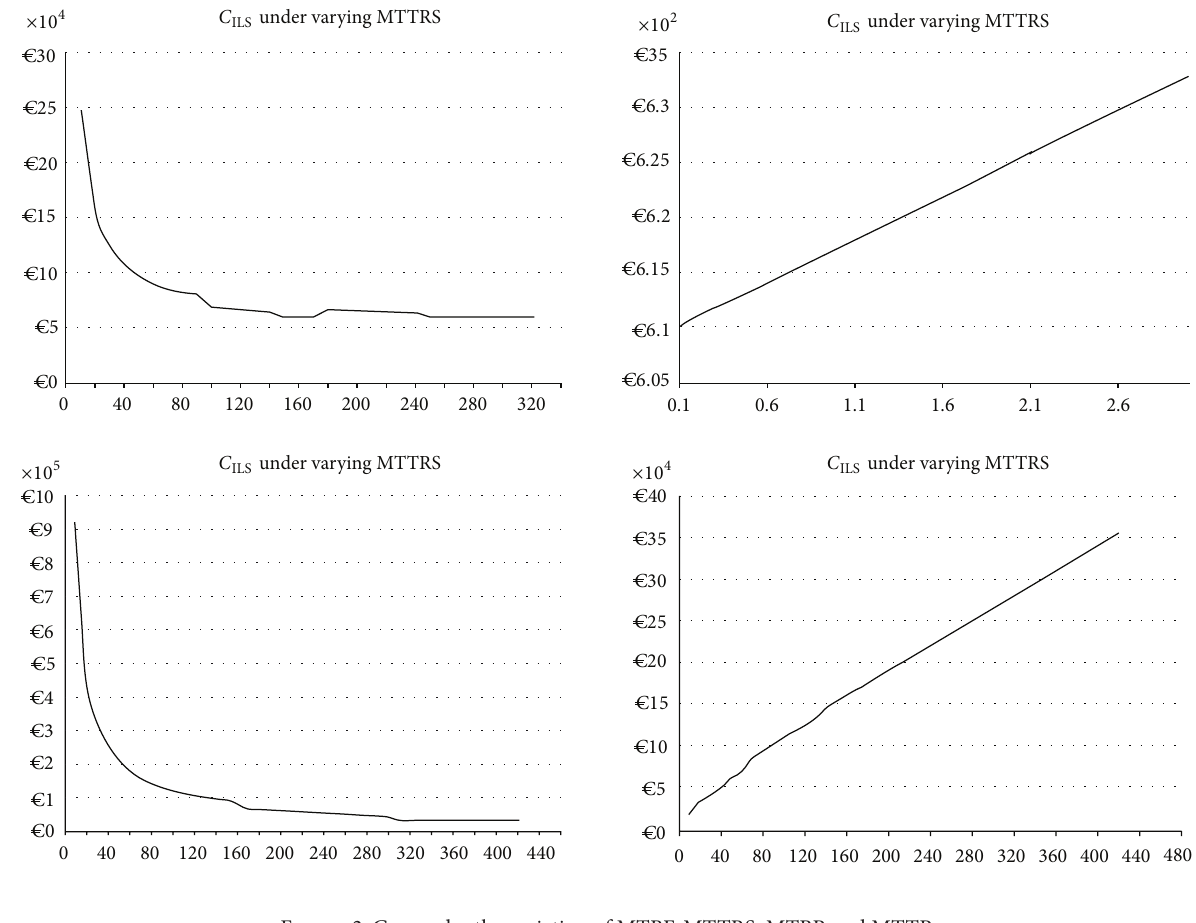
Figure 2: 𝐶 under the variation of MTBF, MTTRS, MTBP, and MTTP. ILS